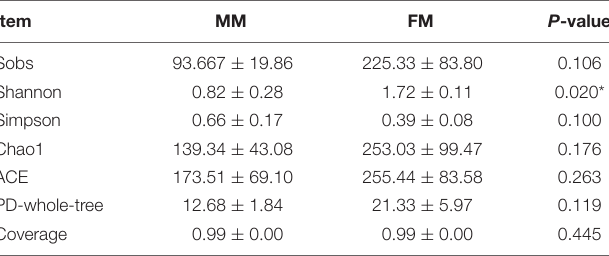
TABLE 1 | Differences in intestinal microbial alpha diversity in swamp eels of different sex. Item